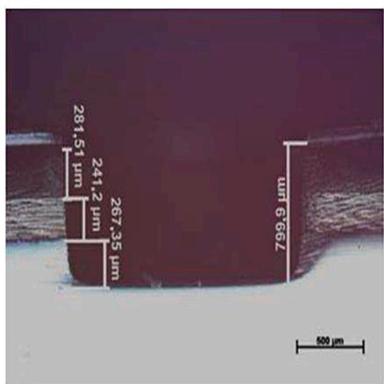
Cross-sectional view of the drilled hole in the CFRP/steel/ CFRP sample.